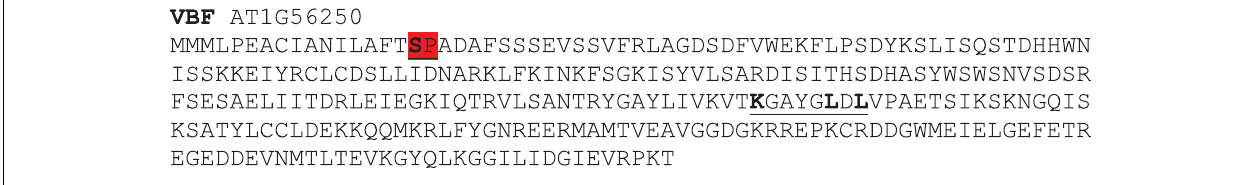
Frontiers in Plant Science | Plant-Microbe